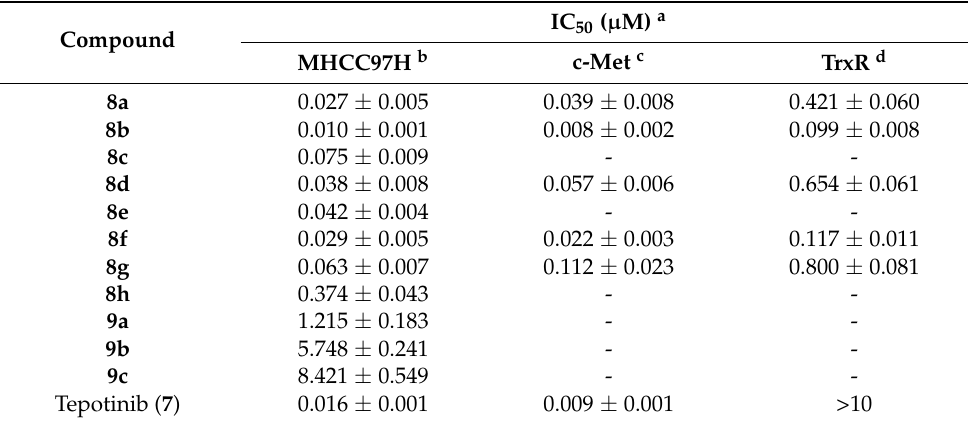
Table 1. In vitro antiproliferative activity of compounds 8a – h , 9a – c and tepotinib 7 against MHCC97H cell line, and inhibitory activity of some selected compounds and tepotinib 7 toward c-Met kinase and TrxR.